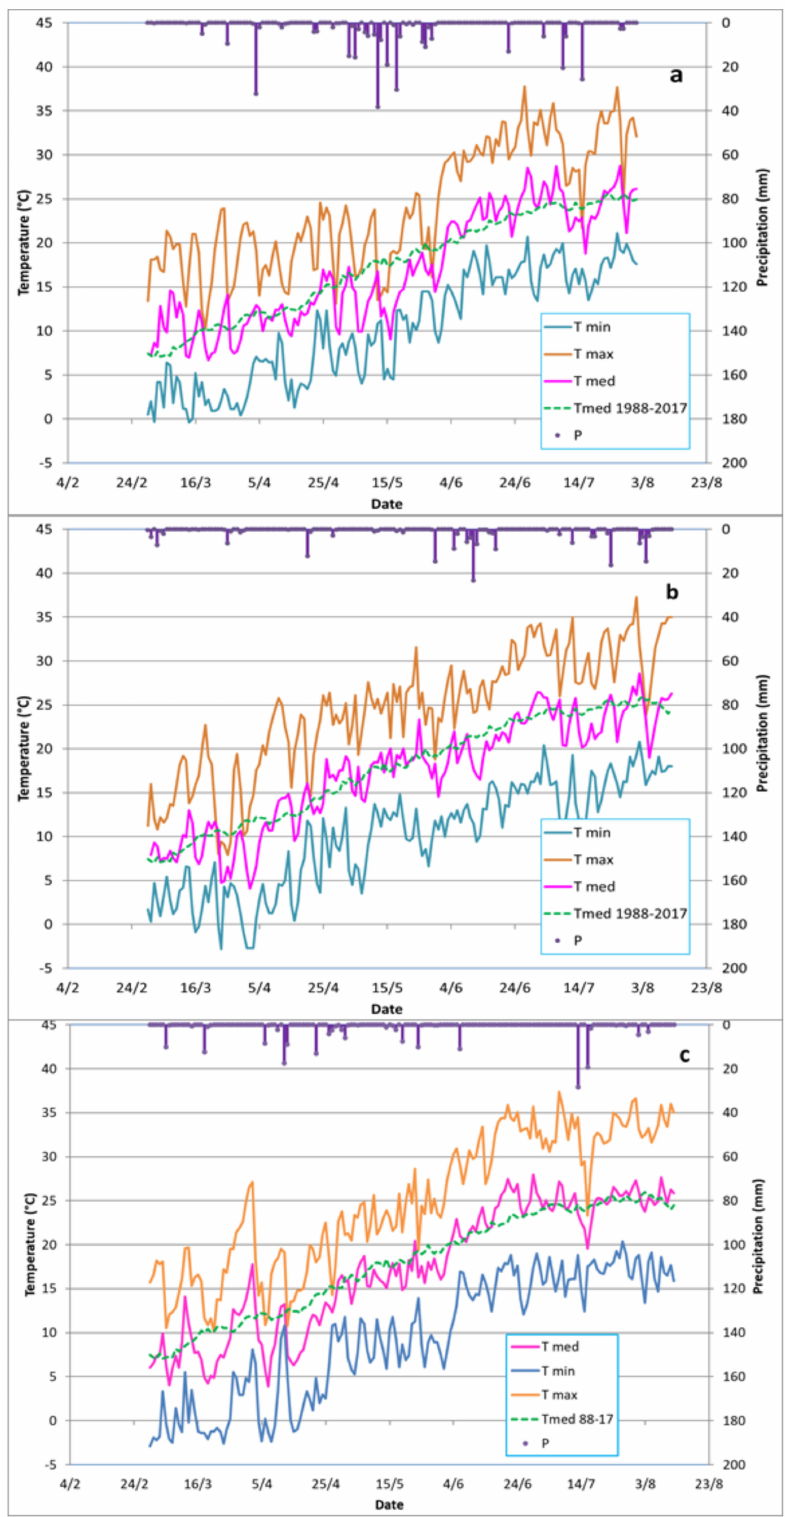
Figure 2. Meteorological data for VM site in 2019 ( a ), 2020 ( b ), and 2021 ( c ). As reference, the 30 year mean air temperature (1988–2017) measured at the Cadriano station was